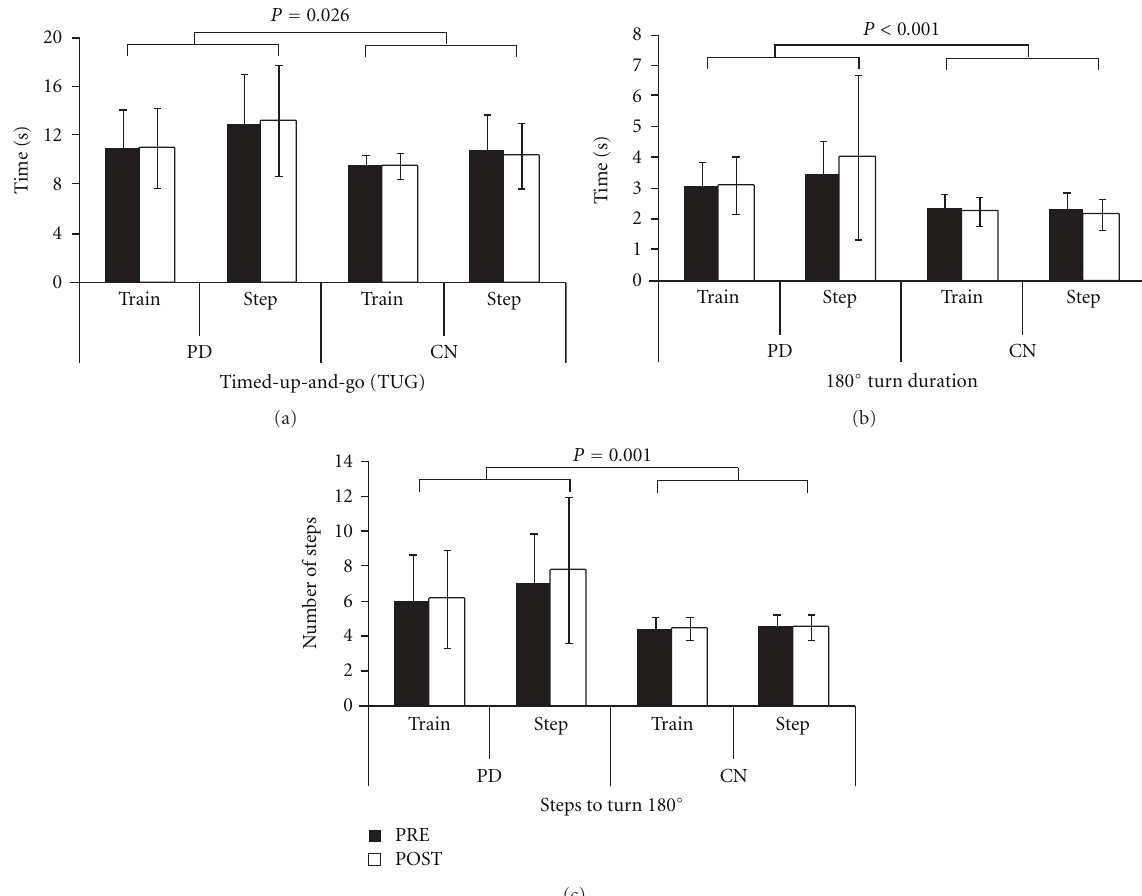
Figure 2: Functional Turning and Turn Performance . Mean timed-up-and-go time (a), 180 ◦ in-place turn duration (b), and number of steps to turn 180 ◦ in-place (c) for PD and controls in the rotating treadmill training group (Train) and the stepping in place group (Step). Brackets indicate significant group e ff ects. Error bars are